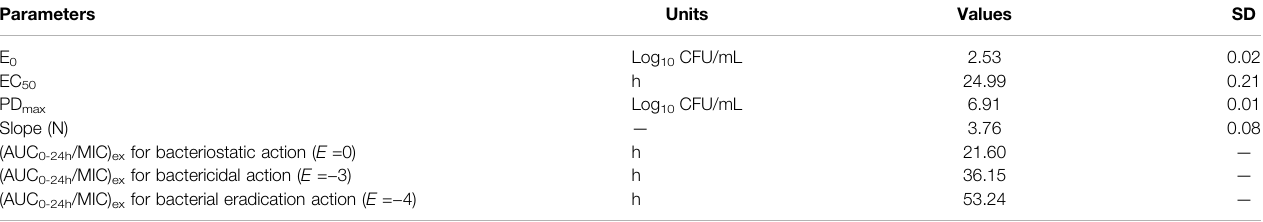
TABLE 5 | Ex vivo pharmacodynamic parameters of avilamycin against Clostridium perfringens . Parameters